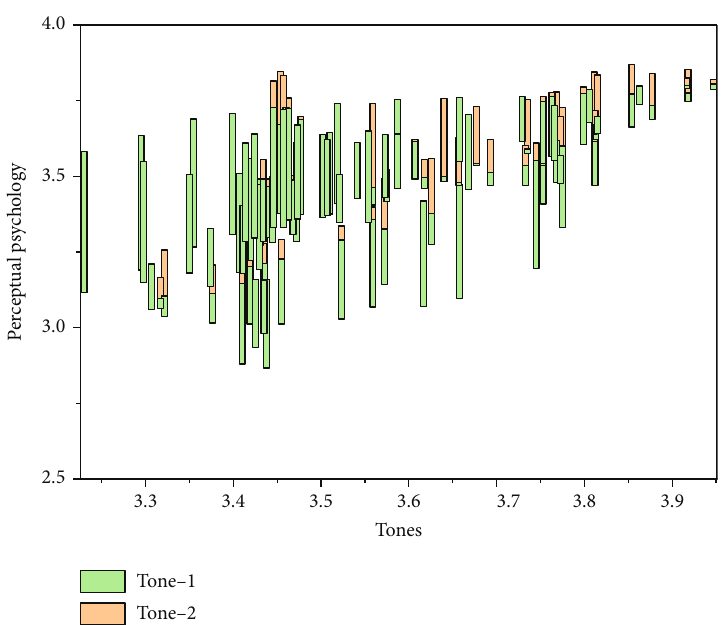
Figure 8: Survey statistics of perceptual